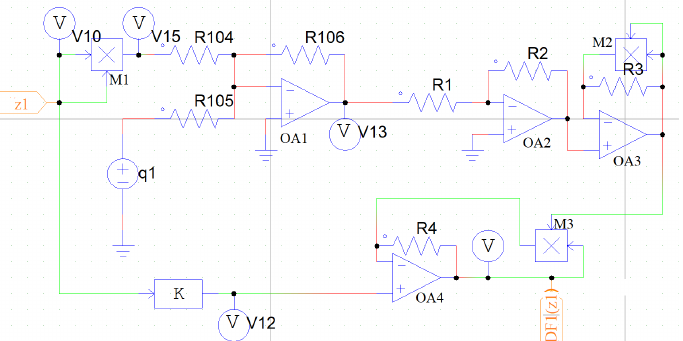
Figure 11. The equivalent circuit diagram of the force due to the dry-friction f DF1 ( z 1 ) . The resistance values are: R 104 = R 105 = R 106 = R 1 = R 2 = R 3 = R 4 = 100 k Ω , k = 0.2413. OA 1 to OA 4 are the Op-Amps, M 1 to M 3 are the multipliers, q 1 is the dc voltage source with the value of a 2 proportional block. (Color